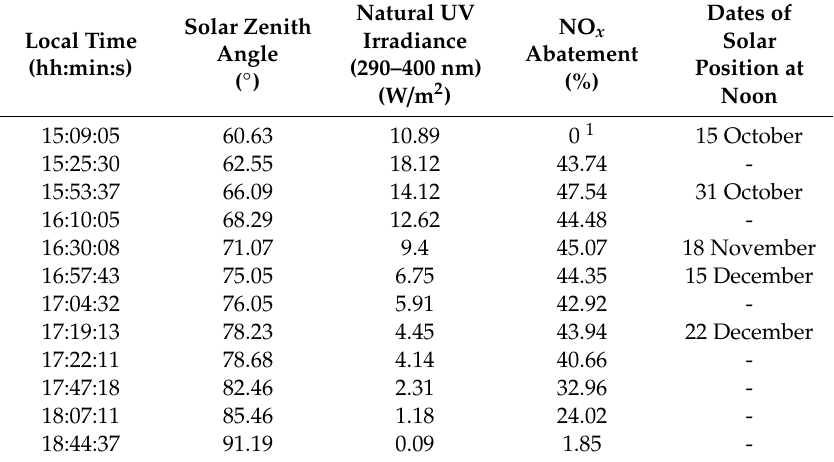
Table 2. NO x abatement measured with a novel method at solar zenith angle characteristic to dates of the solar position at noon for location with a latitude of 51.83 ◦ N.